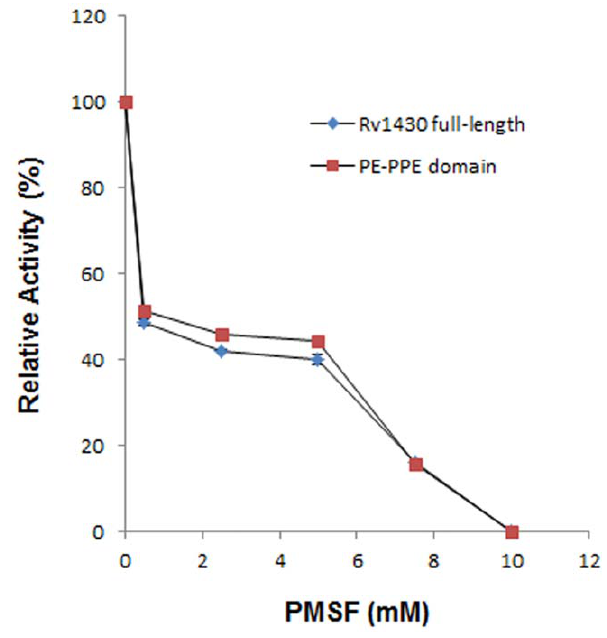
Figure 6. Effect of NaCl concentration on the esterase activity of Rv1430 and PE-PPE domain measured on substrate pNPC6.